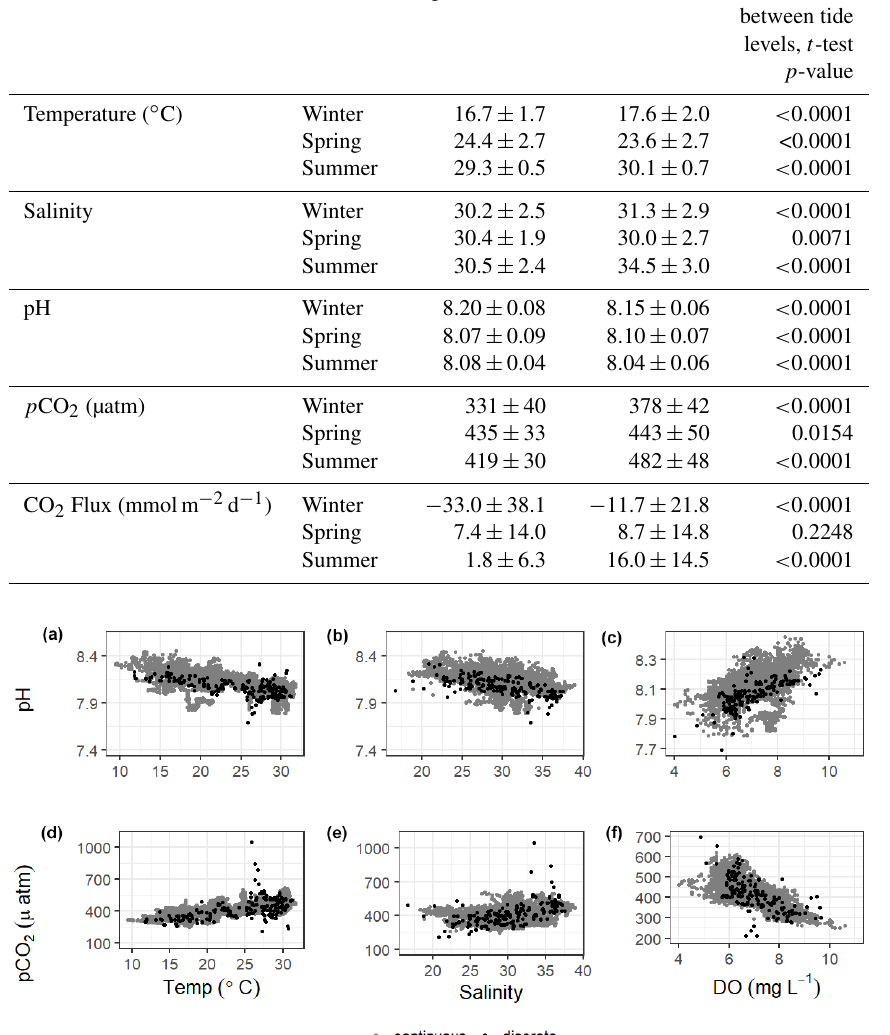
Figure 7. Correlations of pH and p CO 2 with temperature, salinity, and DO from continuous sensor data (gray) and all discrete data